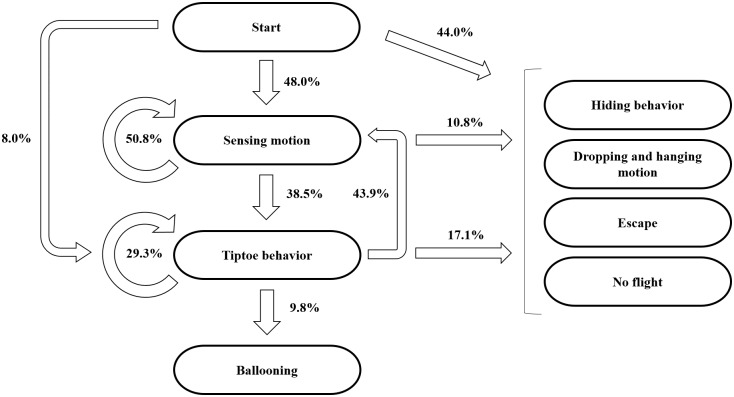
Takeoff process for tiptoe ballooning.The probabilities are calculated based on the total number of behaviors at each stage (see Fig 5B).